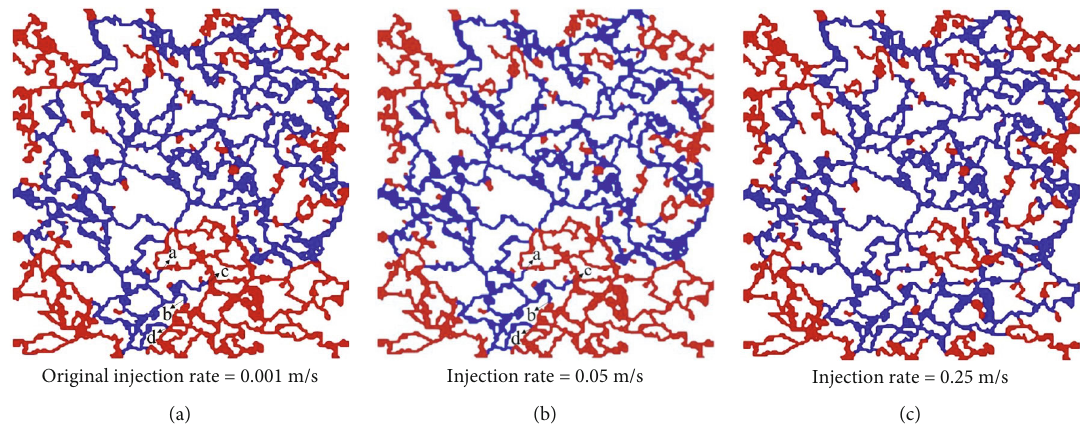
Figure 12: Oil and water two-phase distribution versus injection rate. (a) Original injection rate = 0 : 001 m/s . (b) Injectionrate = 0 : 05 m/s . (c) Injectionrate = 0 : 25m/s .